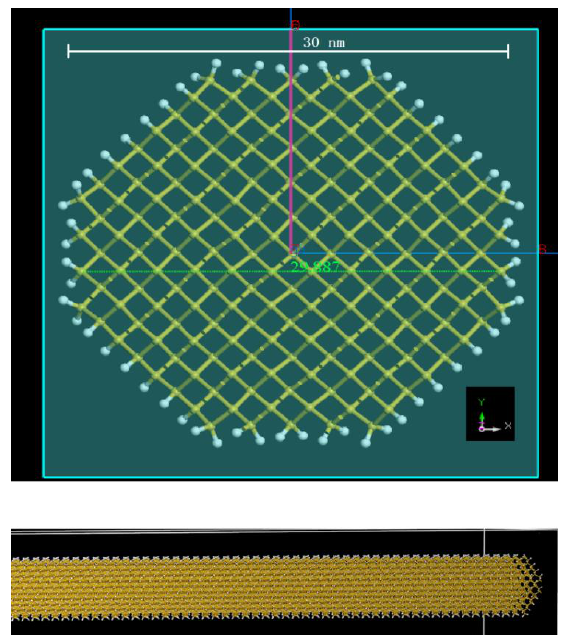
Figure 3. Structure model of Si NW in simulation, in which the top picture shows cross-section structure and the bottom picture shows the lateral view of Si NW structure.